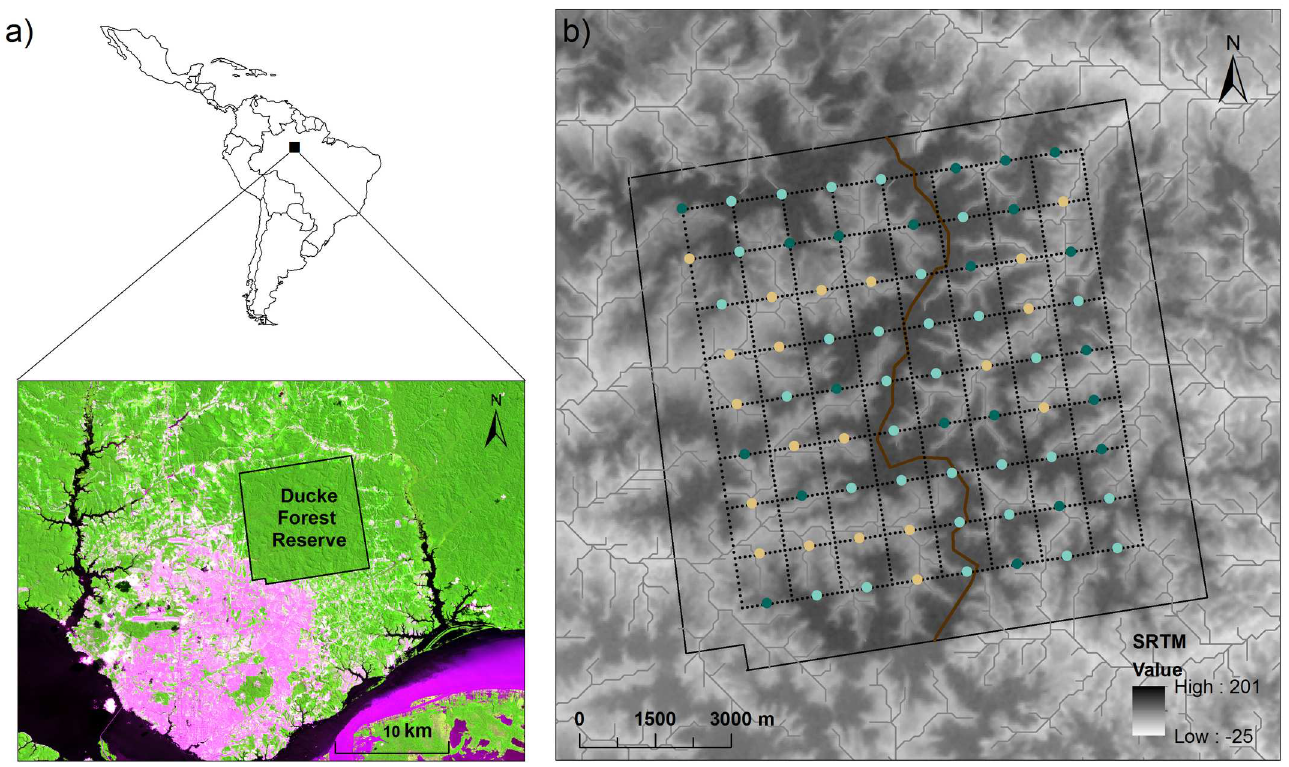
Fig 1. Location of Ducke Forest Reserve(DFR), Manaus, Amazonas State, Brazil. Locationof DFR in relationto the city of Manaus and to the main rivers (a); Topography, streams and the system of trails (dashedlines) in the study area, showingthe 72 samplingplots (b). The brown line marks the division of the reserve into eastern ( n = 34) and western ( n = 38) watersheds. The colors of the plots indicate the three environmental groups identified by K-means partitioning.Beige dots represent Low areas ( n = 20), pale green dots represent High areas ( n = 31), and dark green dots represent Slope areas ( n =